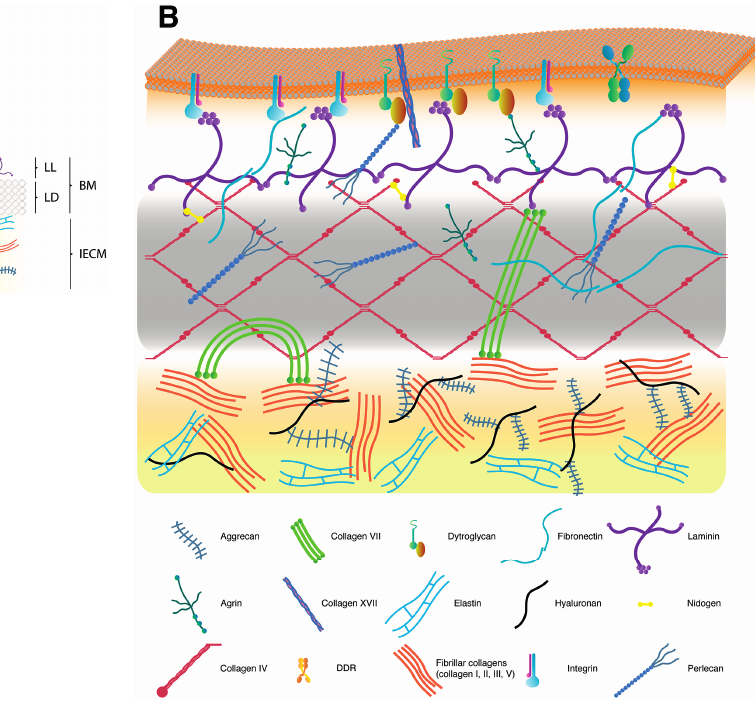
Figure 1. Schematic model of the extracellular matrix and the basement membrane. ( A ) Extracellular matrix (ECM). In many tissues, such as glandular, stratified and certain complex epithelia, the ECM is formed by a basement membrane (BM), which is connected to the epithelial cells, and an interstitial extracellular matrix (IECM), which constitutes most ECM space. Cells adopt basal-apical polarity and interact with BM components through specific cell surface receptors located on their basal side. As in transmission electron microscopy after conventional fixation, the BM is composed of two layers: (1) the lamina lucida (LL), an electron-lucent layer that lies immediately adjacent to the cell; and (2) the lamina densa (LD), an electron-dense layer that comes into contact with the IECM. The lamina lucida is not detectable in electron microscopy specimens fixed by the milder method of freeze substitution. ( B ) Basement membrane. The basic structure of a BM is formed by two independent networks of laminin and collagen IV, which are non-covalently interconnected by nidogen and perlecan. The self-assembled collagen IV network is recruited together with other BM components, including nidogen, perlecan and agrin, to the nascent laminin scaffold. Agrin and perlecan provide additional connections between the BM and the cell surface. Native collagens also have the possibility of contacting cells through plasma membrane receptors, such as DDRs (not shown in the figure). Several molecules, such as collagens VII, XV and XVIII, are known to act as linkers between the BM and the adjacent IECM. For clarity purposes, only collagen VII aggregates, which may interact with fibronectin, laminin, collagen I and collagen IV, and form the anchoring fibrils, are included in the